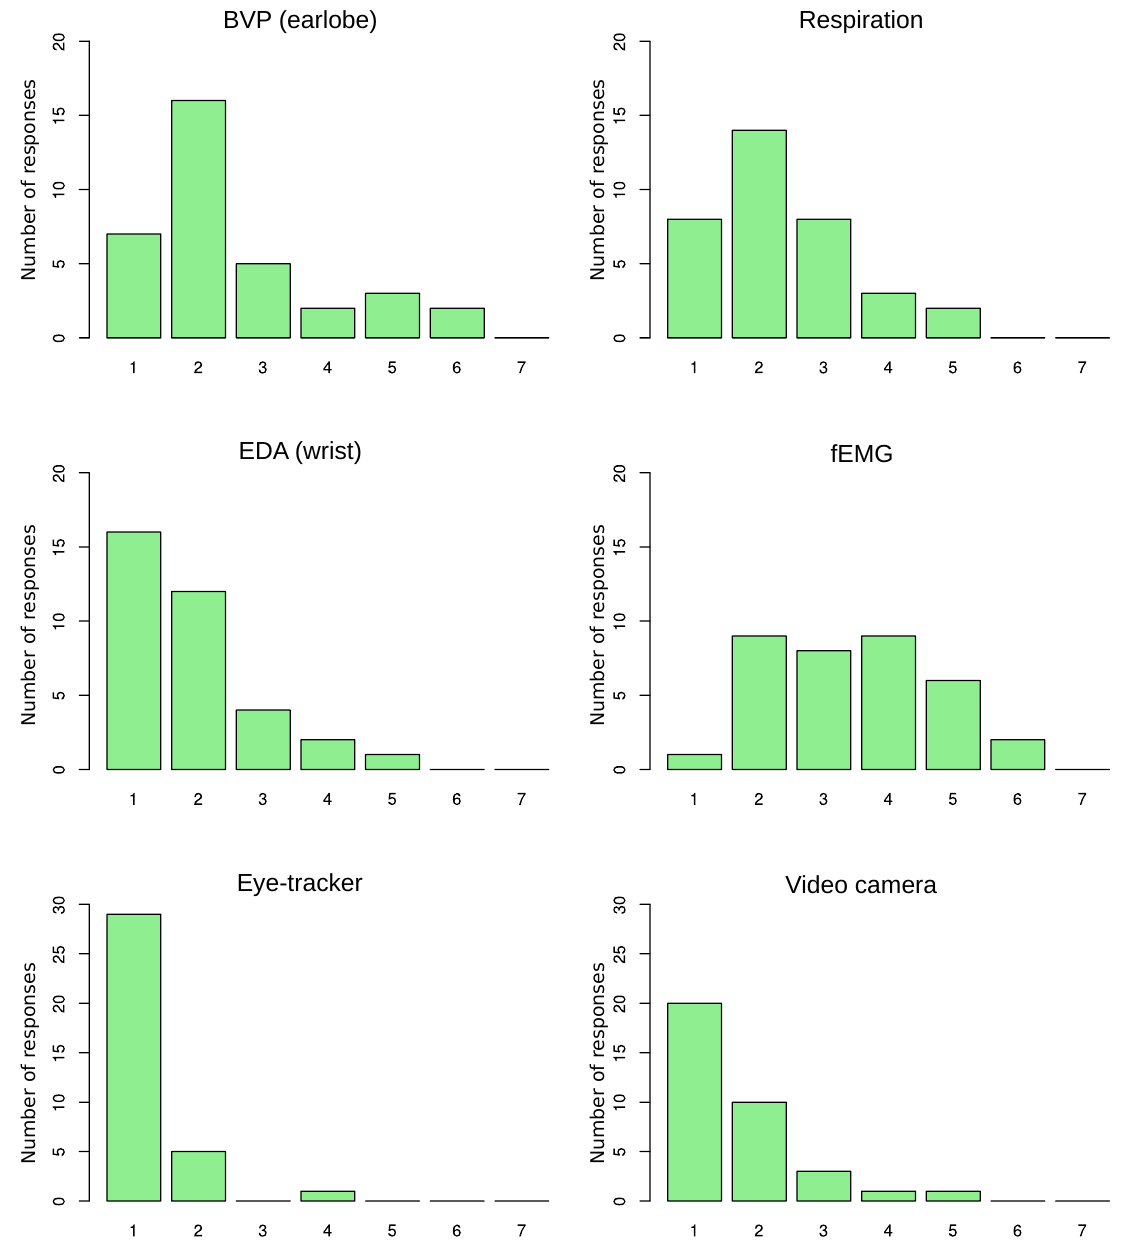
Figure 5. Disturbance rating distribution of